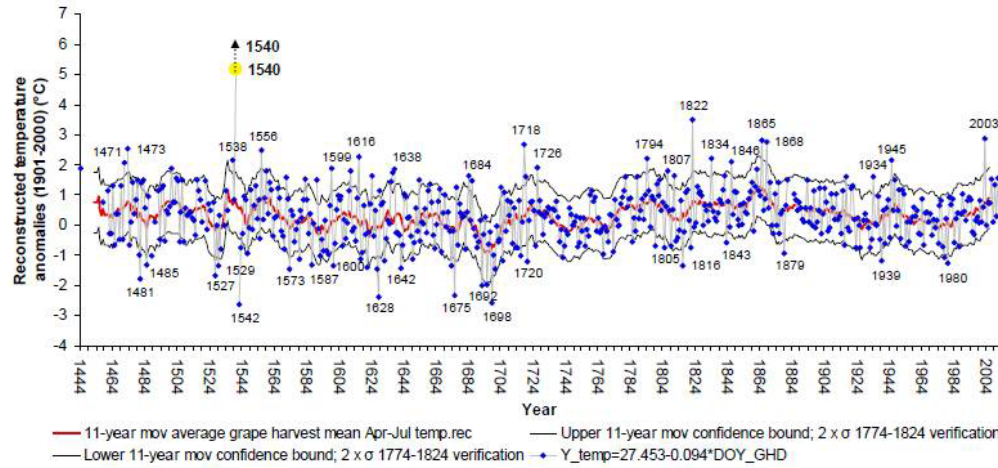
Figure 16. Temperature anomalies compared to the 20th century based on grape harvest dates’ linear regression calculations (Wetter and Pfister,